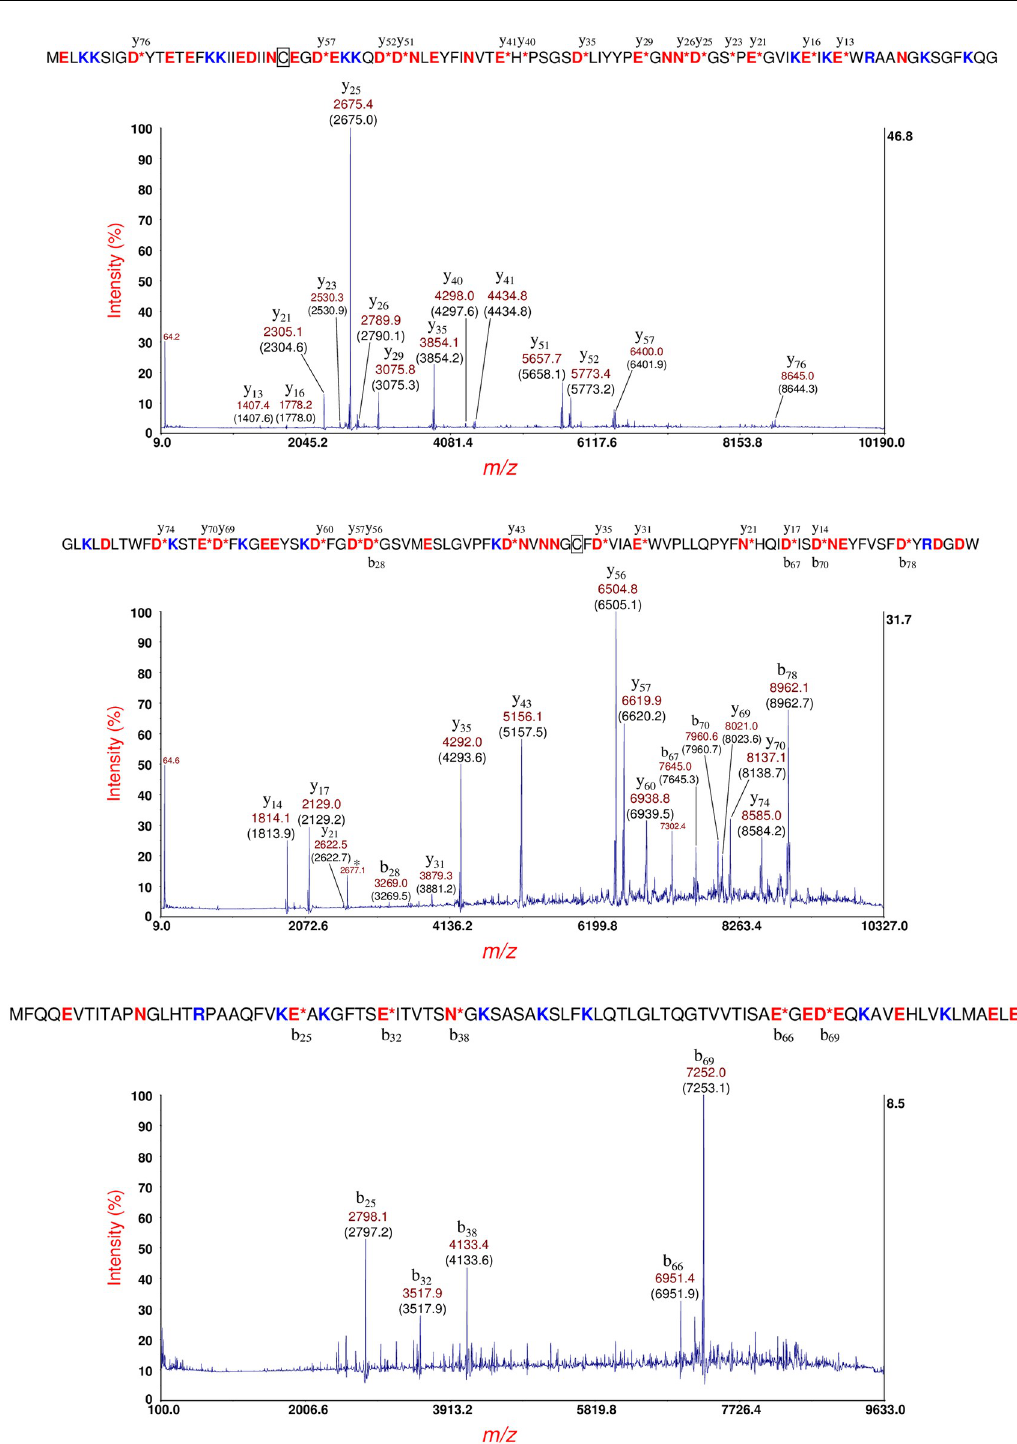
Fig 7. Top panel: MS/MS of the protein ion at m/z 9648 [M+H] + shown in Fig 4 (middle panel). The protein sequence (shown above) is that of the immunity protein (ImBac) of bacteriocin, a plasmid-borne bactericidal enzyme and noted previously. A single cysteine residue (boxed) and is assumed to be in its reduced state. Middle panel: MS/MS of the protein ion at m/z 9778 [M +H] + shown in S2 Fig. The protein was identified as the immunity protein (Im3) of the bactericidal enzyme: colicin E3 another plasmid-borne protein (sequence shown above). This protein also has one cysteine residue (boxed). Bottom panel: MS/MS of the protein ion at m/z 9122 [M+H] + that appears in the middle and bottom panels of Fig 4. As with RM7806, this protein ion was identified as HPr (sequence shown above). An asymmetric TIS was used (-40/+80) to eliminate fragment ion spillover from metastable HdeB at m/z 9066.